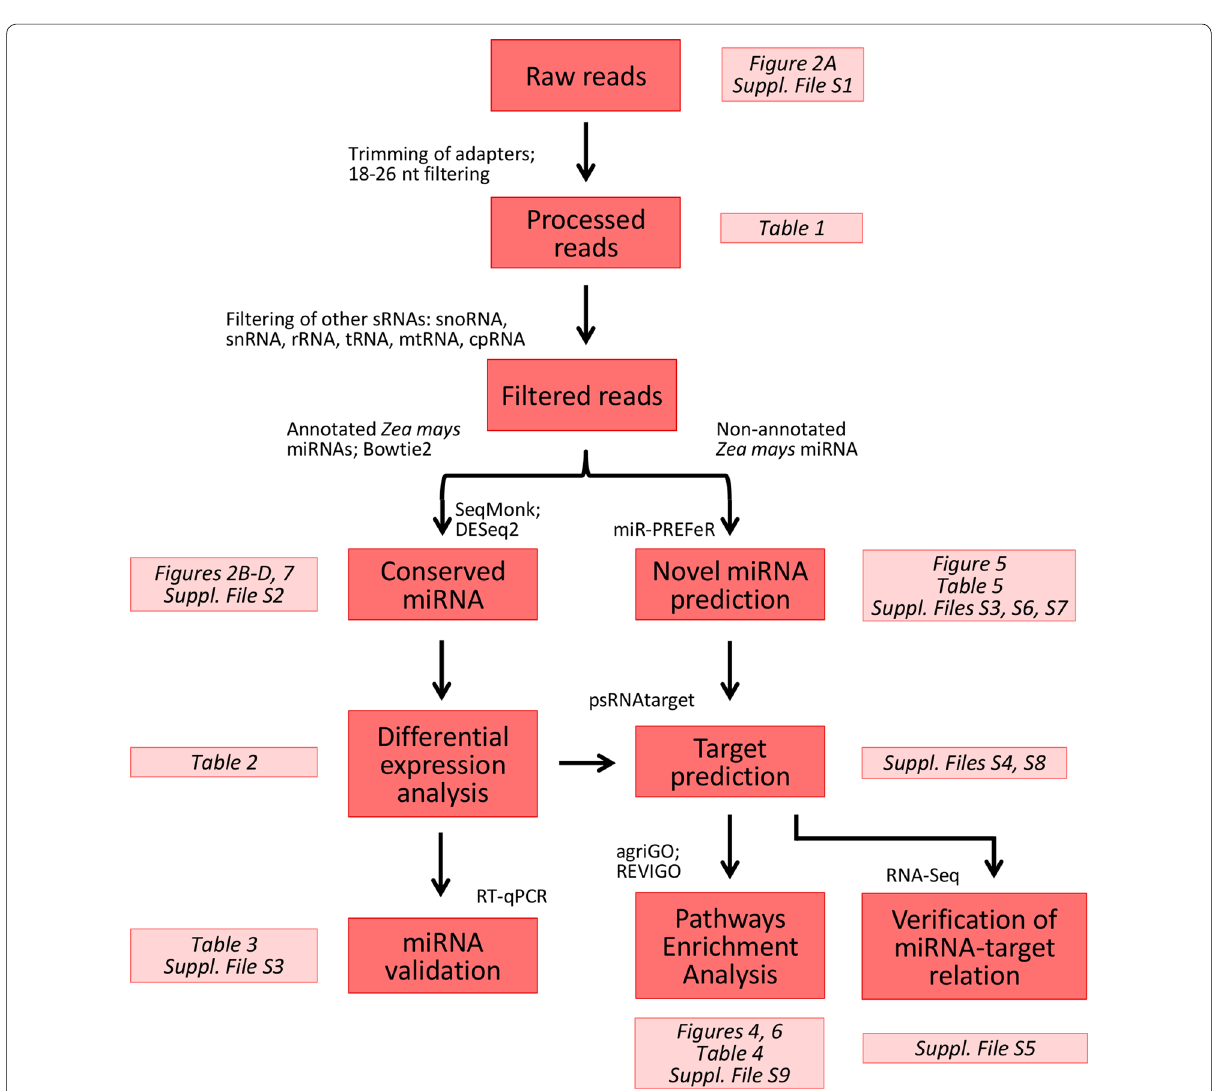
Fig. 1 Schematic overview of the workflow implemented for the identification of differentially expressed regulatory miRNAs and their targets in GM and control maize